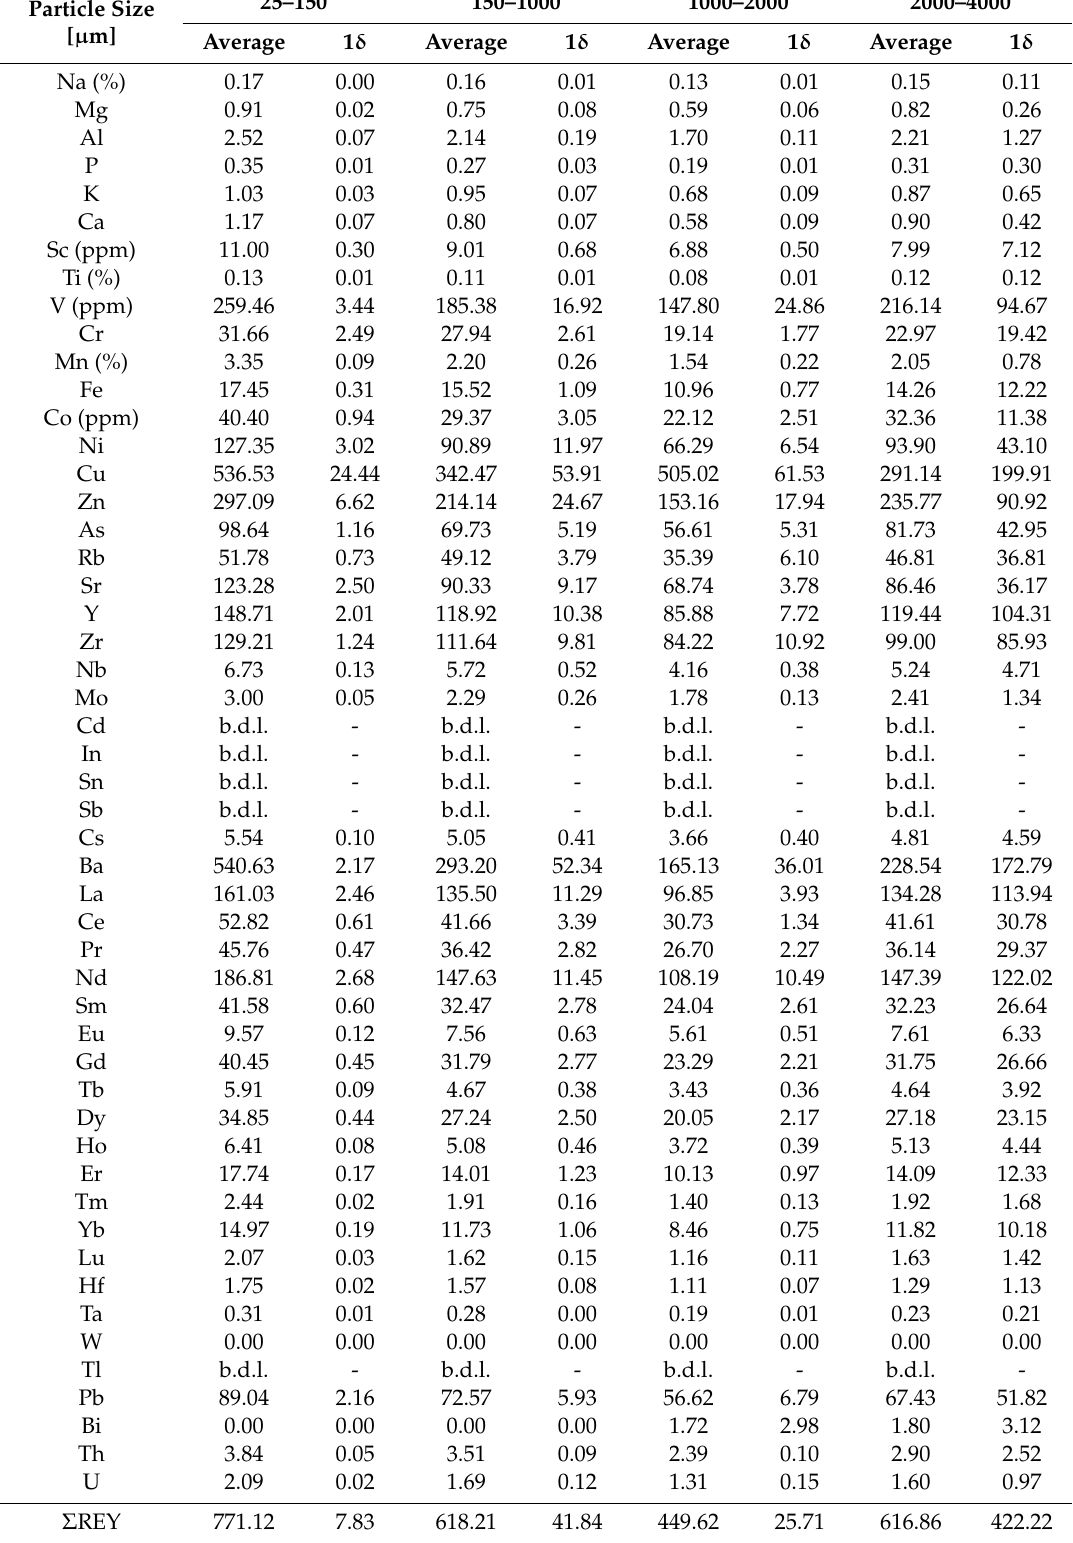
Table 2. Chemical composition of the Aki umber determined by